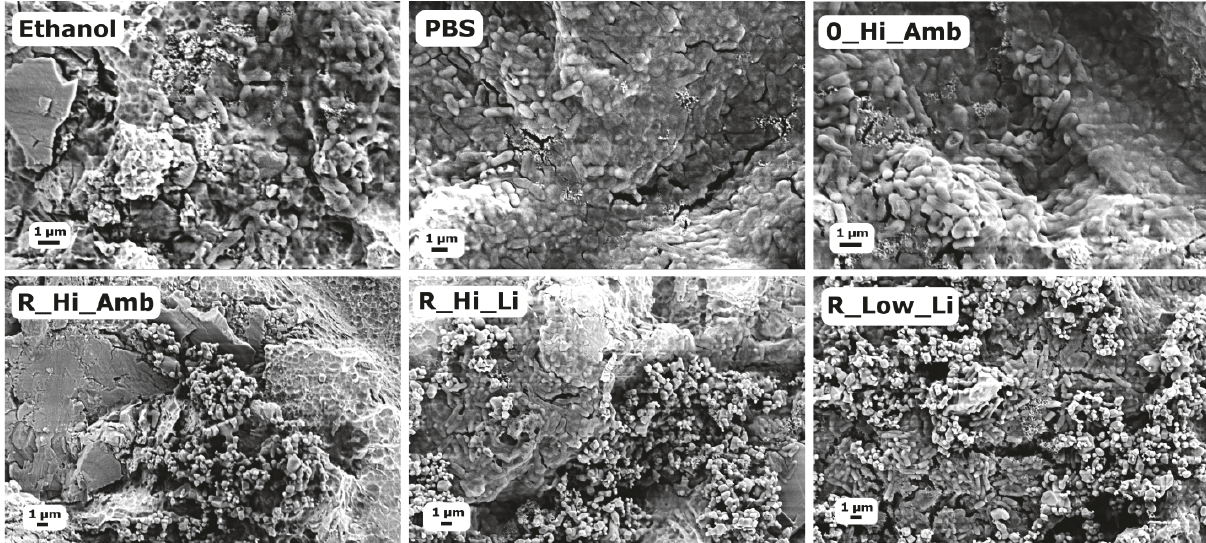
Figure 6: SEM micrographs of P. aeruginosa on the Ti surfaces after the different debridement treatments.